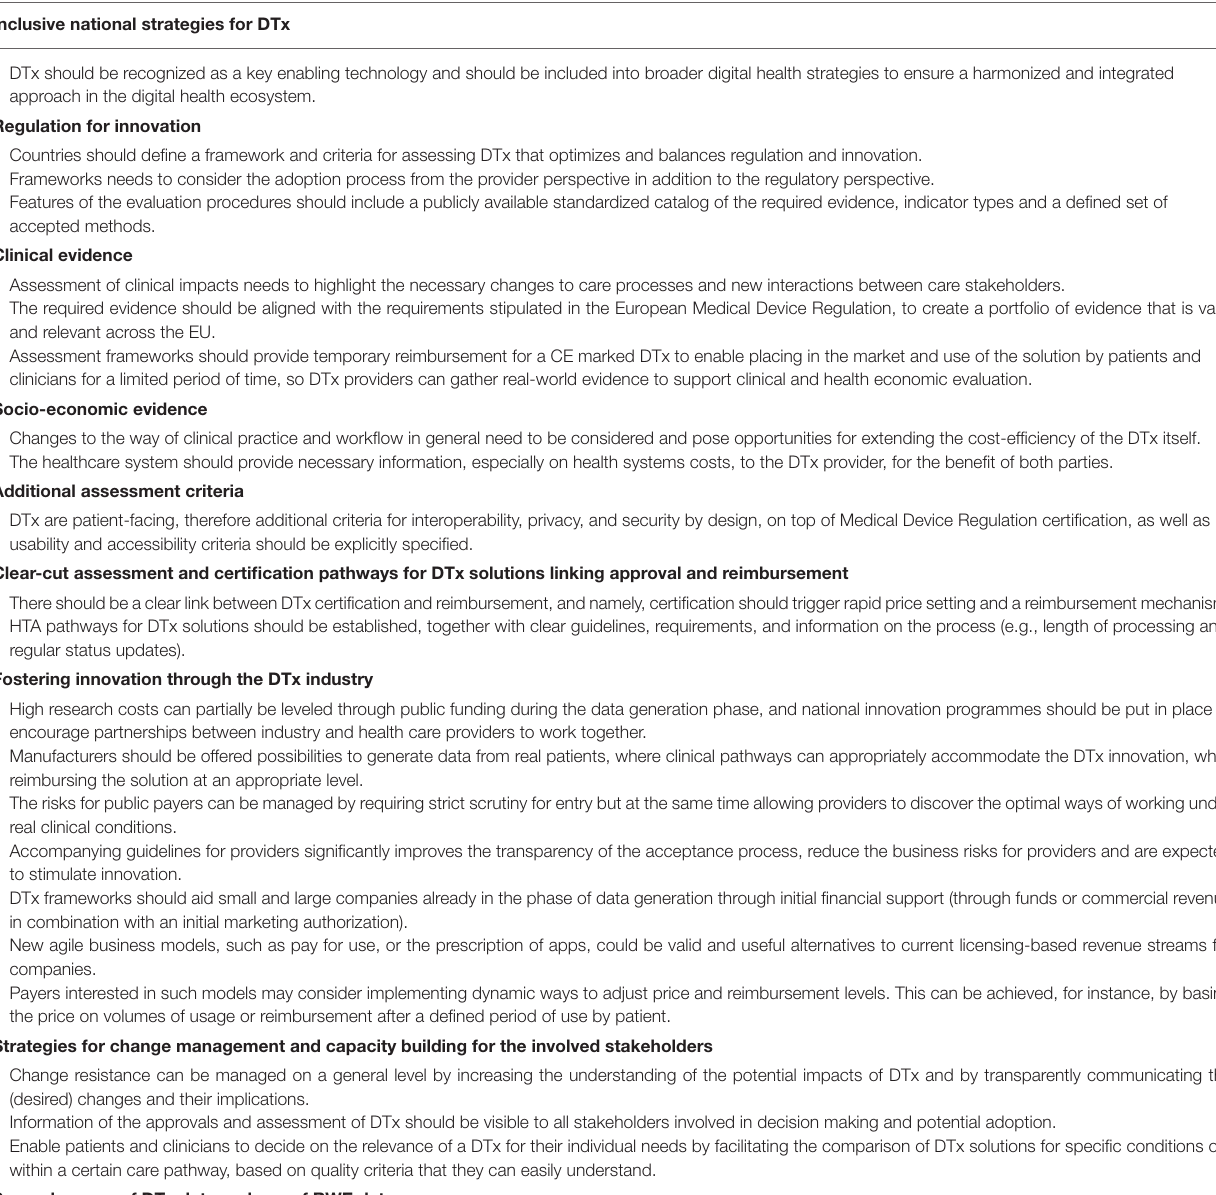
TABLE 1 | Summary of the success factors identified through this